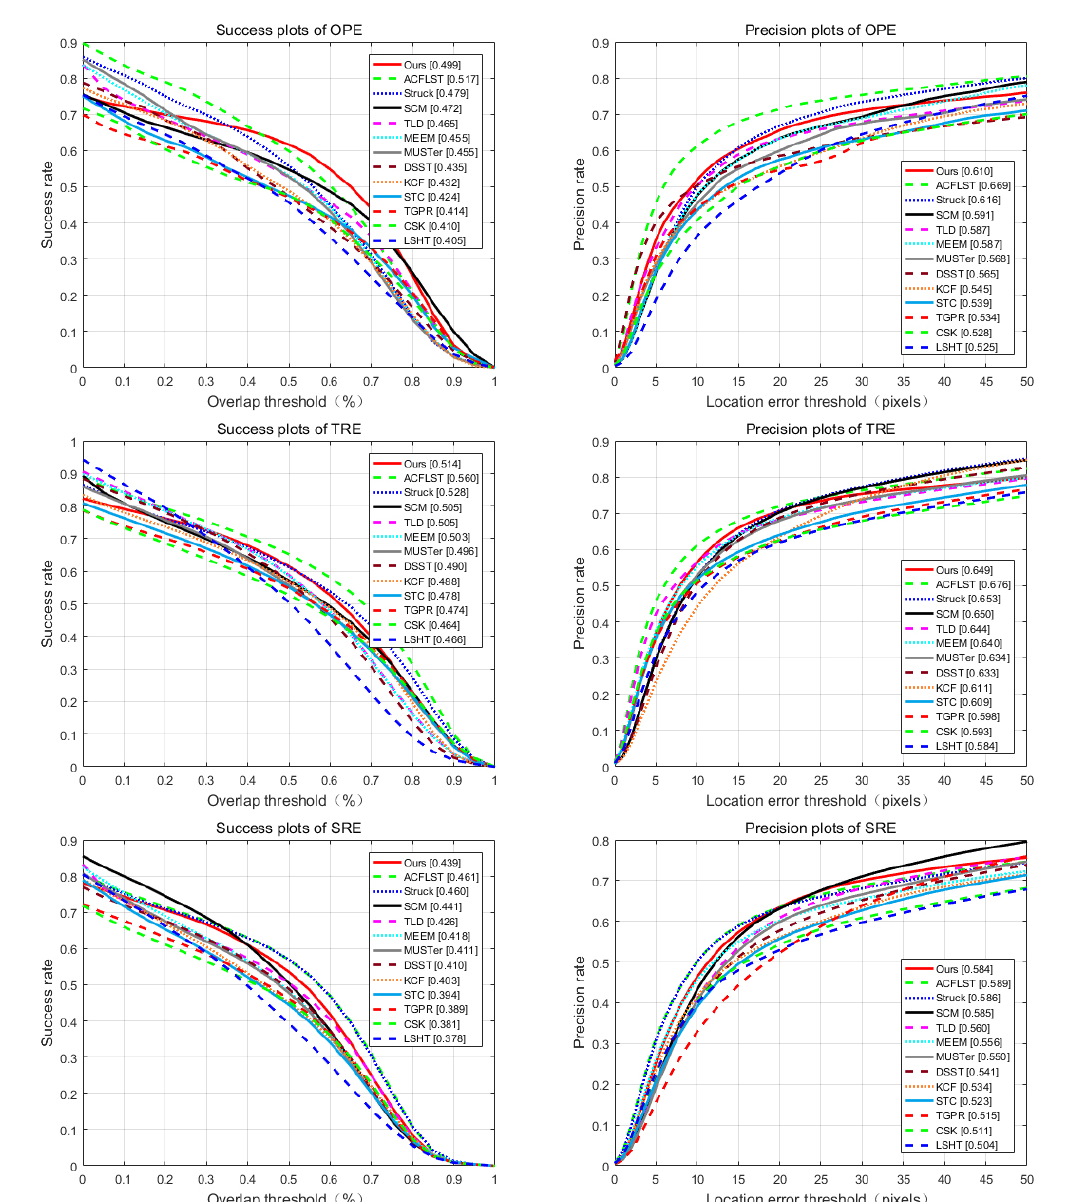
Figure 5. Performance of distance precision and overlap success plots on the test